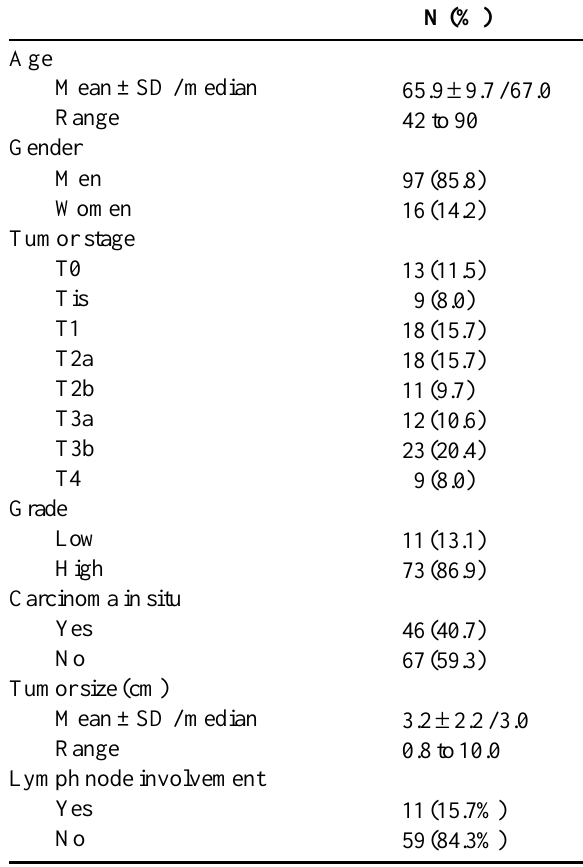
Table 1 – Patients